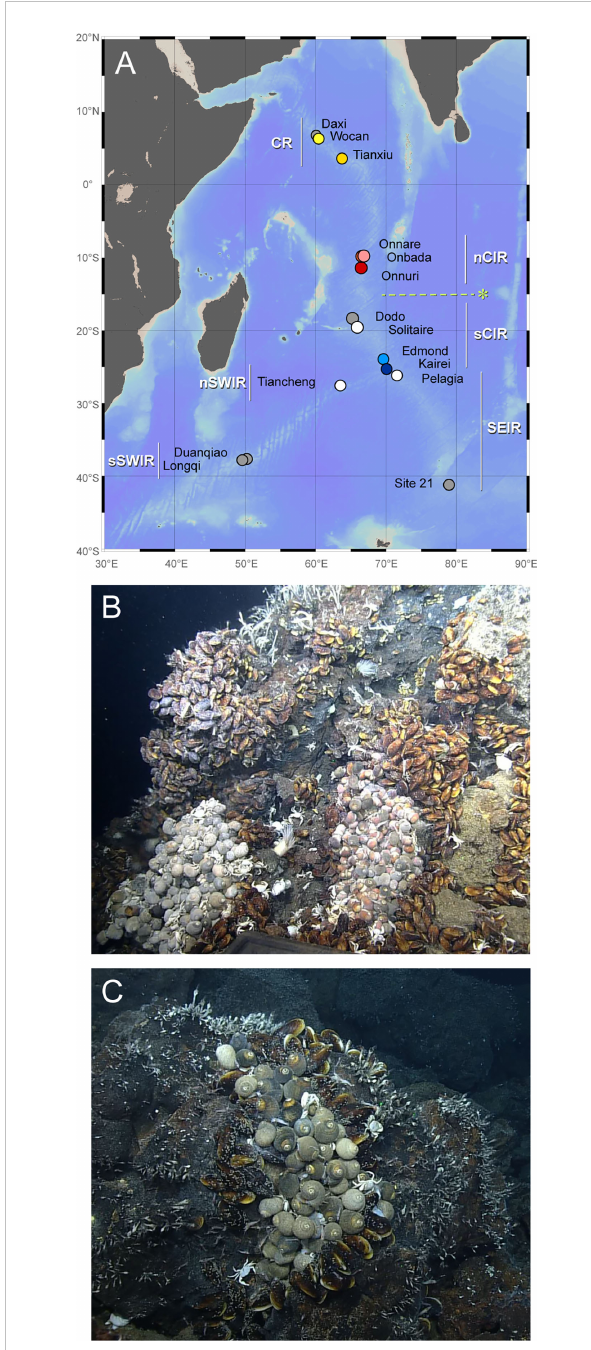
FIGURE 1 Sampling locations and hydrothermal vent fi elds in Indian Ocean reported to date. (A) The sampling sites of Alviniconcha snails along Carlsberg Ridge and Central Indian Ridge. The map was created using Ocean Data View v. 5.6.3 with the General Bathymetric Chart of the Oceans (GEBCO) 2014 grid. Colored circles represent sampling locations. White and gray circles represent the vent fi elds where Alviniconcha snails were observed but not analyzed in this study and not observed to date, respectively (Nakamura et al., 2012; Zhou et al., 2018; Gerdes et al., 2019; Sun et al., 2020). The abbreviations are described in Table 1. The dashed line with “ * ” represents the phylogeographic boundary observed from Alviniconcha snails in this study. Vent community with Alviniconcha snails and Bathymodiolus mussels at the Onnare vent fi eld (B) and Onbada vent fi eld (C)